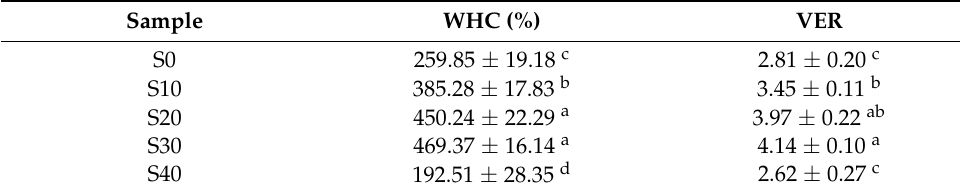
Table 3. Rehydration properties of different formulations based